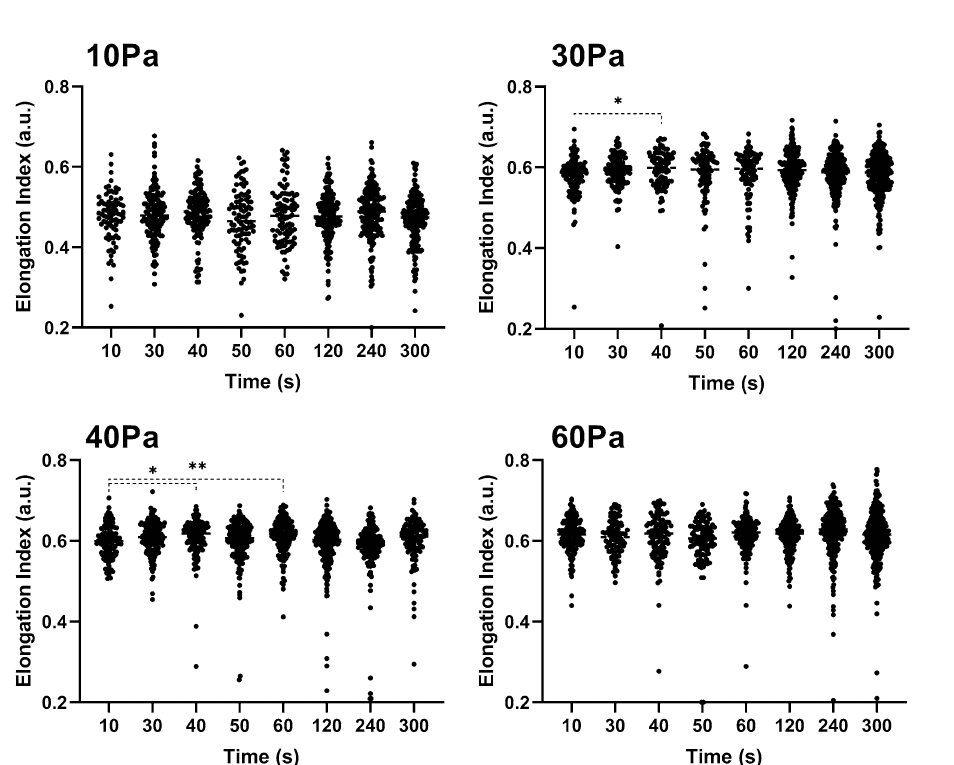
Figure 3. The elongation index of visualised red blood cells exposed to 10, 30, 40, and 60 Pa over the 300-s duration. * p < 0.05. ** p <